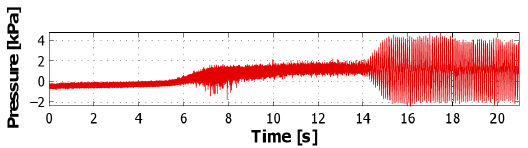
Figure 3: Pressure registered at gauge p s − imp 1 during one of dy- namic